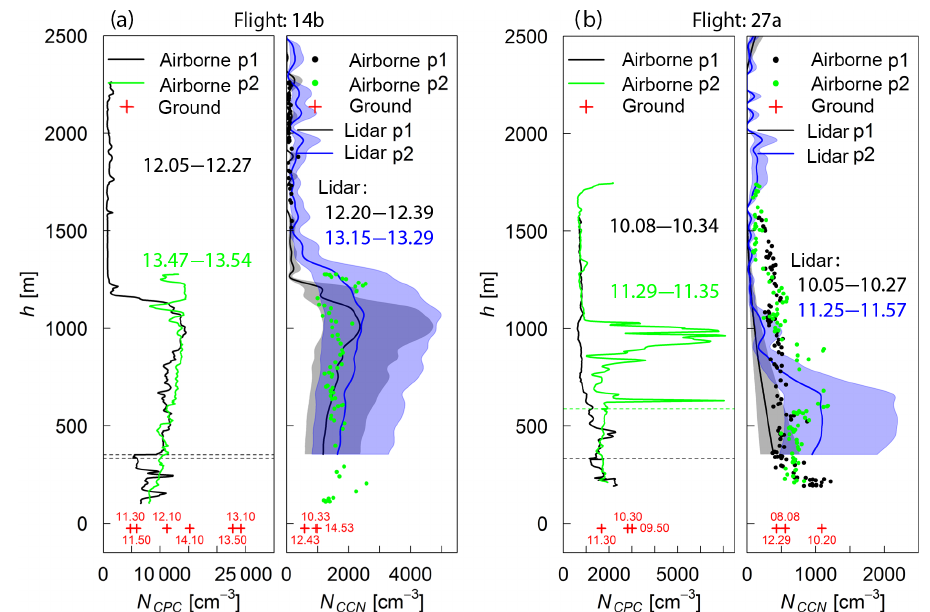
Figure 10. The figure shows profiles of the PNC (solid line; shown on the left side of each panel) and CCN-NC (shown on the right) conducted during flights 14b (a) and 27a (b) . The airborne in situ measurements of the CCN are shown as dots and lidar-based measurements as a solid line with shaded area. Furthermore the ground-based measurements (red crosses, measured at the same time) of the respective parameters. Two airborne profiles p1 (black) and p2 (green) are shown for each flight. The shaded area around the lidar-based CCN-NC profiles symbolizes the uncertainty of factor of 2. Profiles p1 (black) and p2 (green) of flight 14b were recorded between 12:05 and 12:27 and between 13:47 and 13:54UTC, respectively. The corresponding lidar-based profiles (lidar p1; black, and lidar p2; blue) were determined in the period 12:20–12:39 and 13:15–13:29UTC, respectively. Profiles p1 (black) and p2 (green) of flight 27a were recorded at 10:08–10:34 and 11:29–11:35UTC, respectively. The corresponding lidar-based profiles were determined in the period 10:05–10:27 and 11:25–11:57UTC, respectively. The horizontal black and blue dashed lines represent the height in which different vertical sections of the flight have been combined to the respective shown profiles.